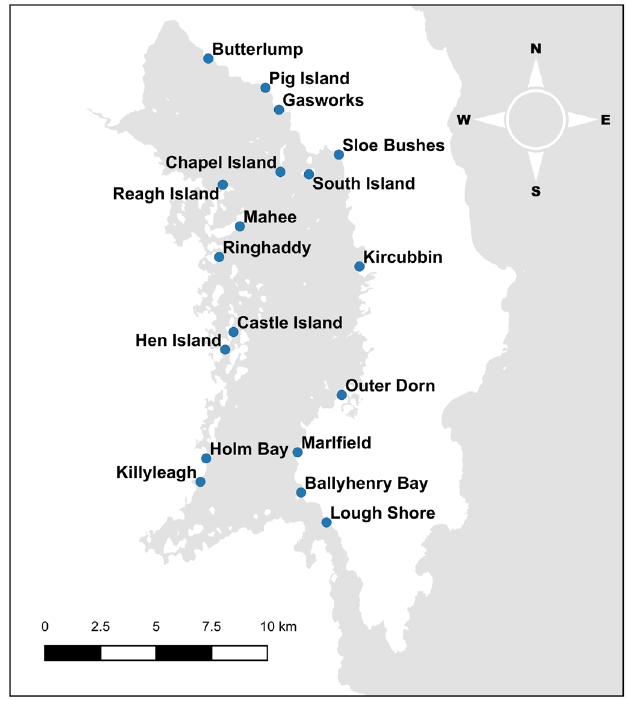
Fig. 1. LocationsofsampledsitesaroundStrangfordLough(54.477 ° N, 5.603 ° W), Northern